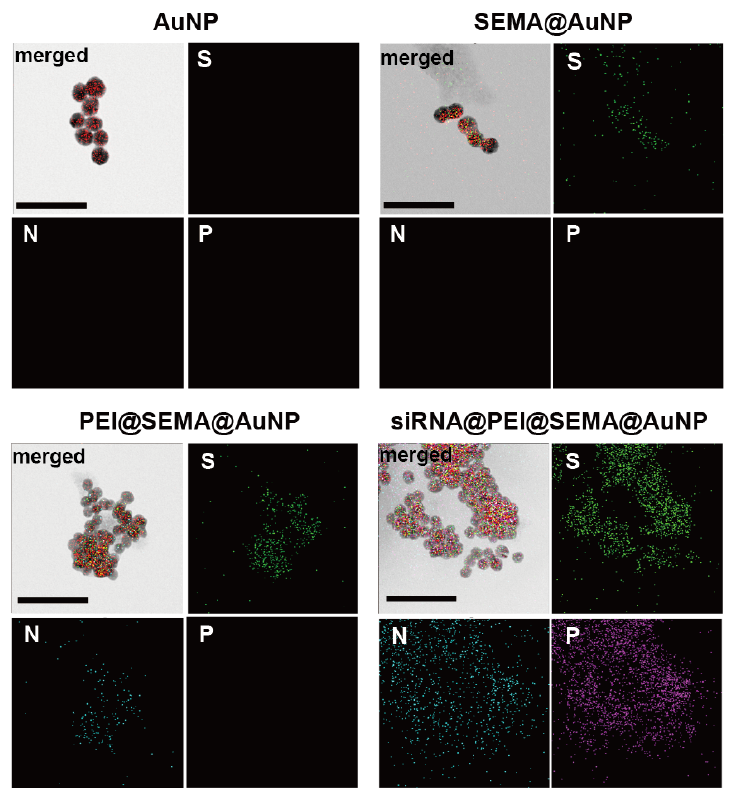
Figure 4. Elemental mapping images of surface modified AuNPs by TEM. Particles were visualized and elementally mapped for S, N, and P (green, blue, and purple, respectively). Merged images are TEM images overlapped with respective maps of respective atoms. siRNA@PEI@SEMA@AuNPs were loaded with 2.5 µg of siRNAs. (Scale bar = 50 nm)